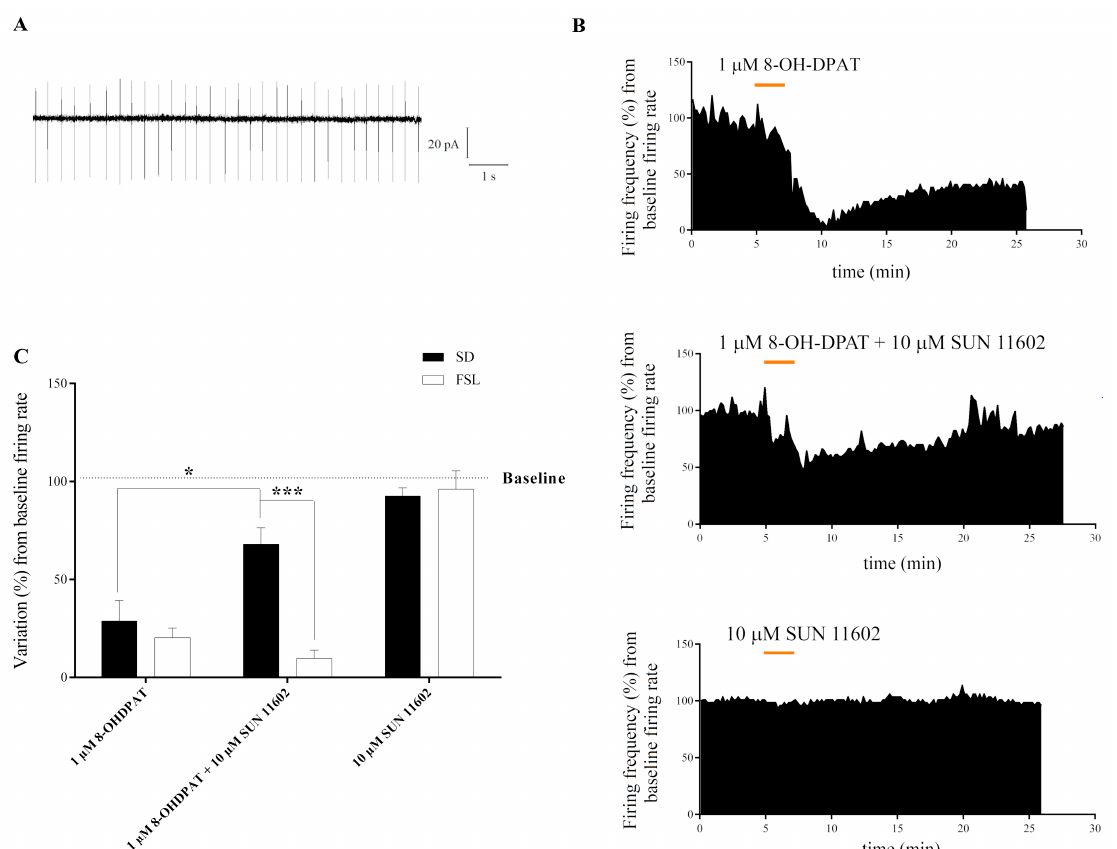
Figure 3. Analysis of dorsal raphe nucleus (DRN) neuron firing properties after 5HT1AR and/or FGFR1 agonist bath application. ( A ) Trace shows a segment of the loose-patch recording explaining the firing characteristics of the recorded DNR serotonergic neurons. ( B ) Representative time—course variation of DRN neuron firing activity after 2-min-long bath application of 1 µ M 8-OH-DPAT, 10 µ M SUN 11602, or a combination of them. ( C ) Variation of DRN neuron firing frequency induced by bath application of 1 µ M 8-OH-DPAT and/or 10 µ M SUN 11602 in Sprague Dawley (SD) and Flinders Sensitive Line (FSL) rats. All data are expressed as mean ± SEM. Two-way analysis of variance (ANOVA) F (2, 38) = 51.48, p < 0.0001; Tukey’s post hoc: * p < 0.05; *** p < 0.001. Number of recorded cells (n) SD: 8-OH-DPAT (6), 8-OH-DPAT + SUN 11602 (6), SUN 11602 (6); FSL: 8-OH-DPAT (11), 8-OH-DPAT + SUN 11602 (7), SUN 11602 (8).